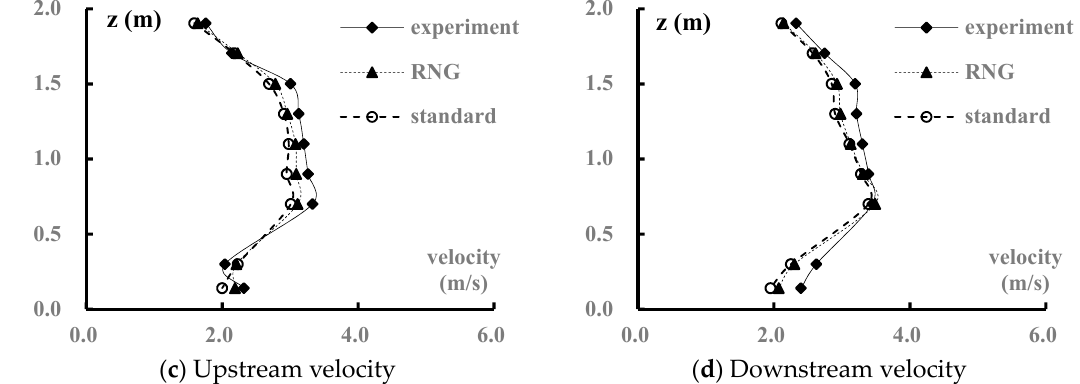
Figure 4. Pressure and velocity calculated using different turbulence models (P = 0.1%).